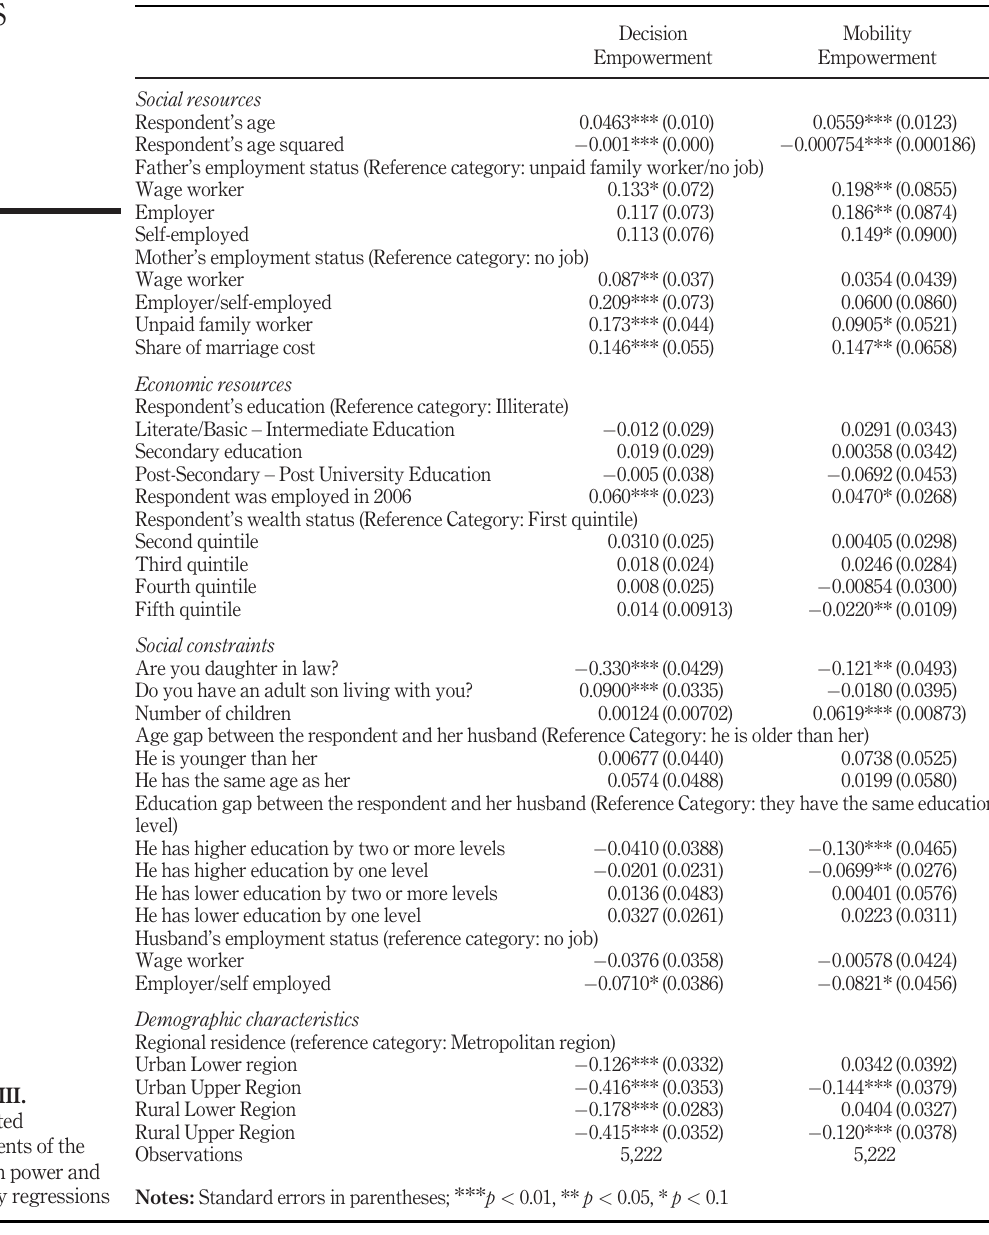
Table III. Estimated coef fi cients of the decision power and mobility